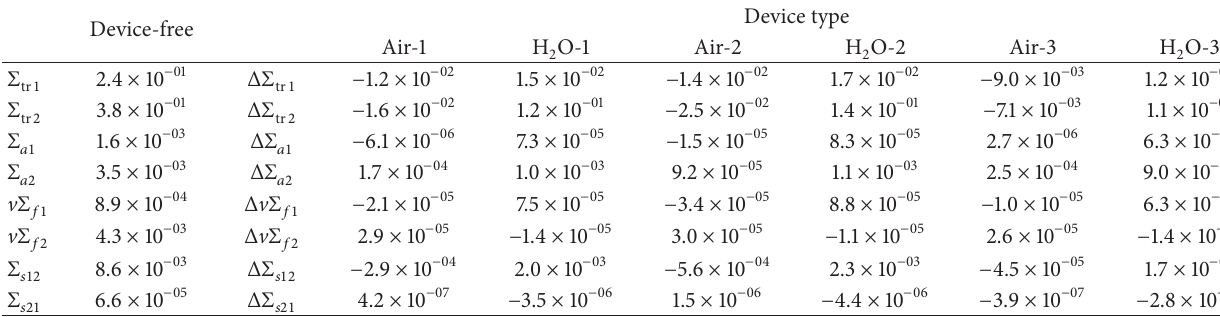
Table 3: Incremental cross sections of liquid zone controllers.